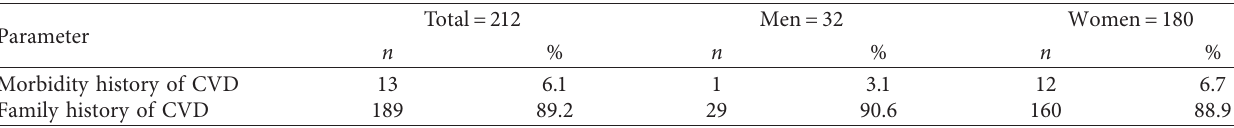
Data presented as n (number of students) and % (percentage). CVD: cardiovascular